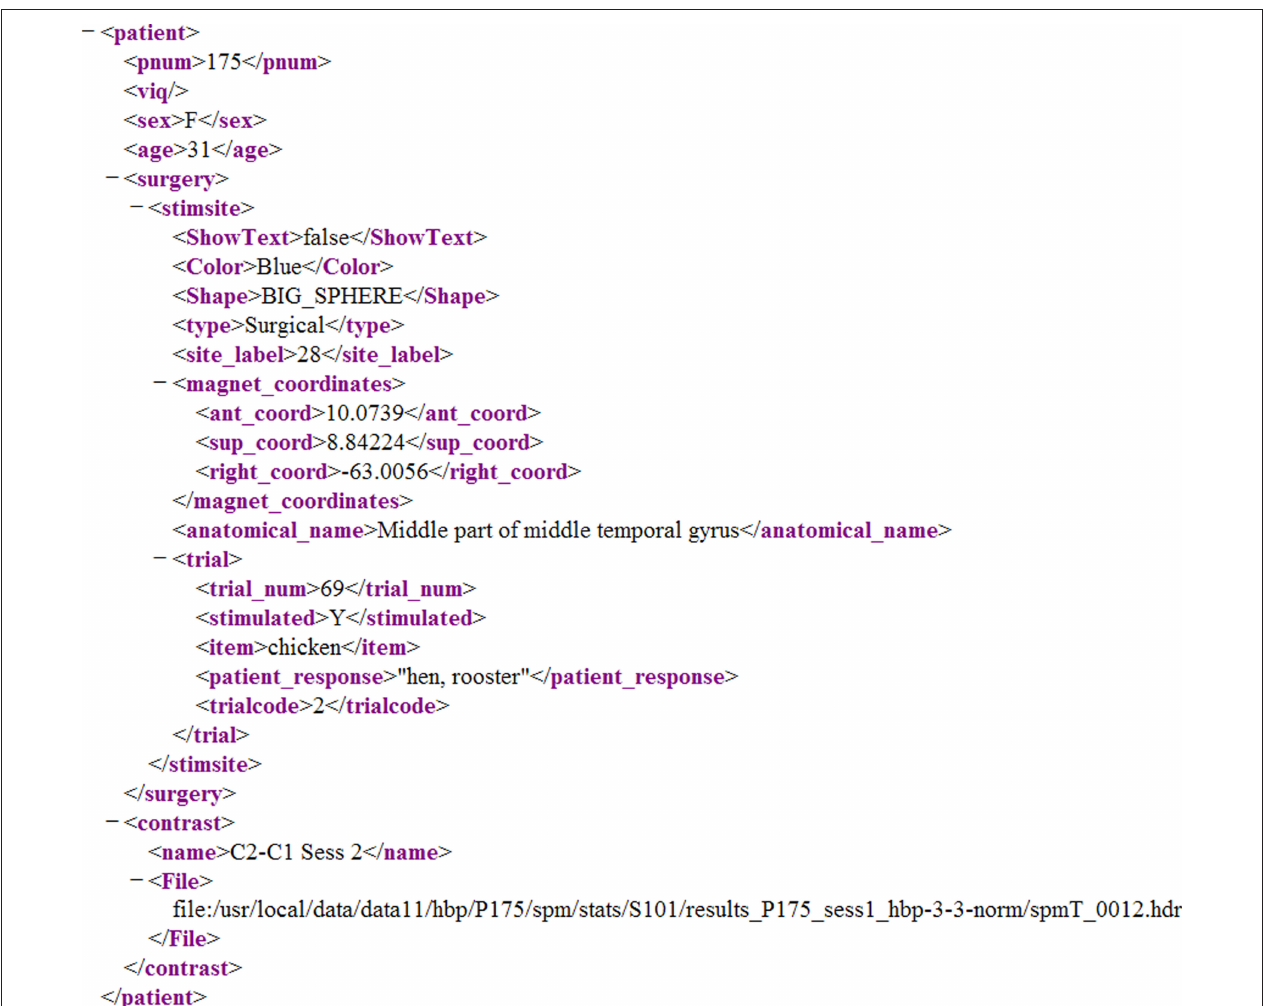
output.FIGURE 4 | XML